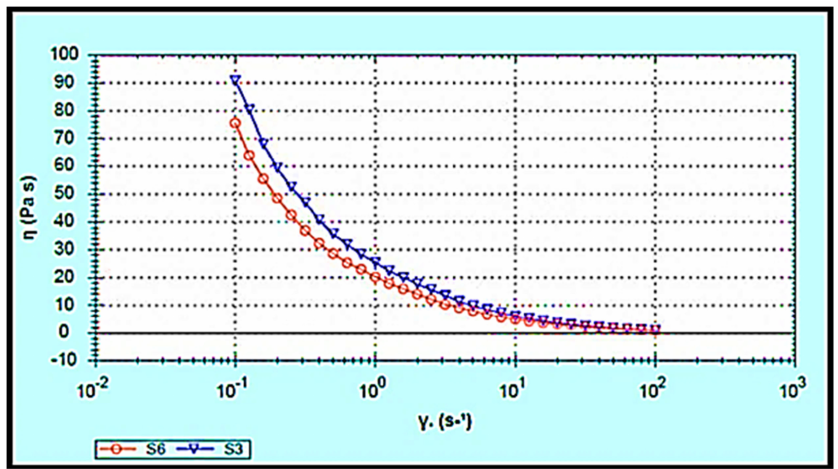
Figure 6. Flow curve of ibuprofen-loaded chitosan-PC90G with gum arabic (S3) and ibuprofen-loaded chitosan with gum arabic (S6). Viscosity vs. shear